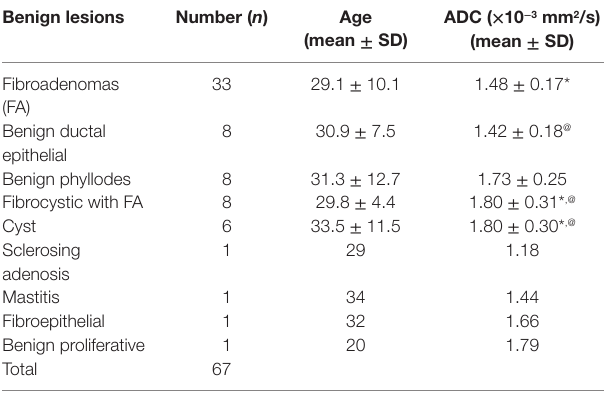
TaBle 4 | Distribution of mean aDc values and age in various histological types of benign breast lesions. Benign